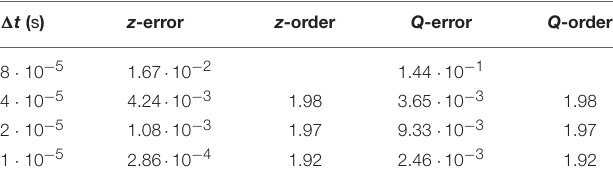
TABLE 3 | Relative errors in bubble position z and flow rate Q at t = 0 . 00144s and estimated convergence orders for the links-in-series test case computed with the midpoint method.